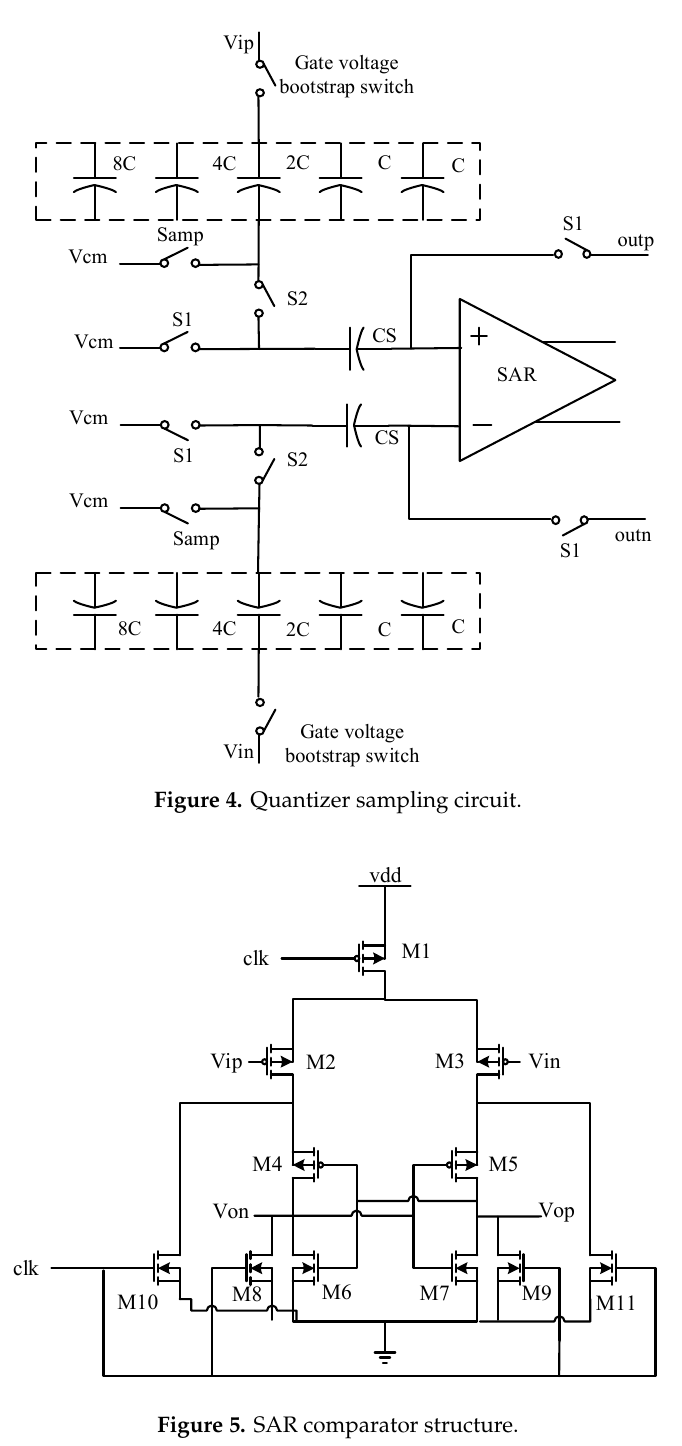
Figure 4. Quantizer sampling circuit.